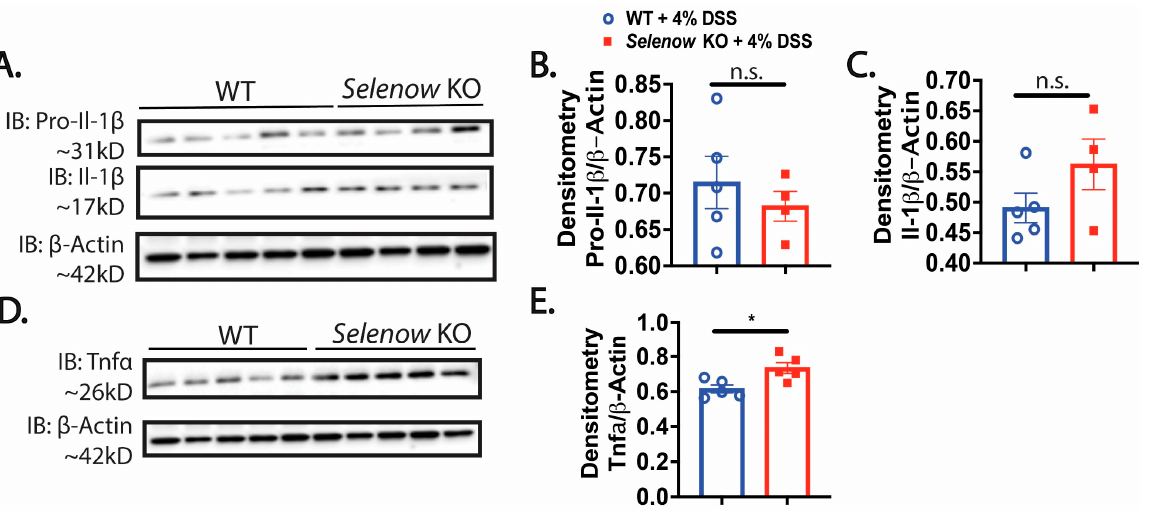
Figure 2. Selenow KO mice have higher colonic inflammation. ( A ) Representative immunoblot of pro-I1-1 β and Il-1 β , and ( B , C ) quantification of pro-I1-1 β and Il-1 β from colonic lysates of WT and Selenow KO mice at day 8 post DSS (WT = 5 mice; Selenow KO = 4 mice). ( D ) Representative immunoblot of Tnf α , and ( E ) quantification of Tnf α from colonic lysates of WT and Selenow KO mice at day 8 post DSS (WT = 5 mice; Selenow KO = 5 mice). Data indicate mean ± SEM. ( B , C , E ) Unpaired non-parametric Mann–Whitney test. * p < 0.05, n.s., not significant.